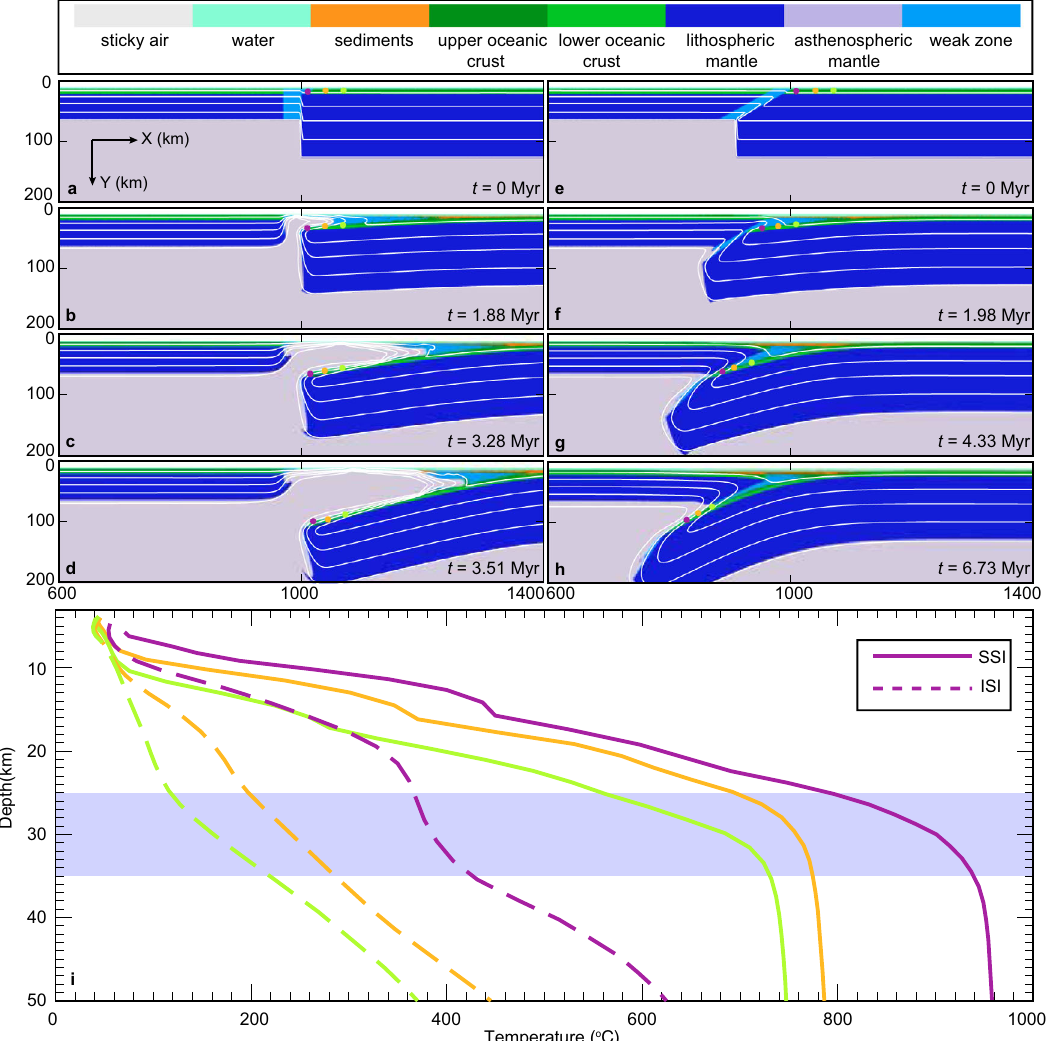
Fig. 3 Thermal evolution of incipient subduction zones. a – d Evolution of spontaneous subduction initiation (SSI), e – h evolution of induced subduction initiation (ISI), and i P-T paths of tracers along the slab surface at 10 km (purple), 30 km (orange), and 60 km (green) distance from the slab tip. The approximate locations of the tracers are indicated by three colored circles in a – h . The depth range where metamorphic soles are typically formed is highlighted in light blue in i